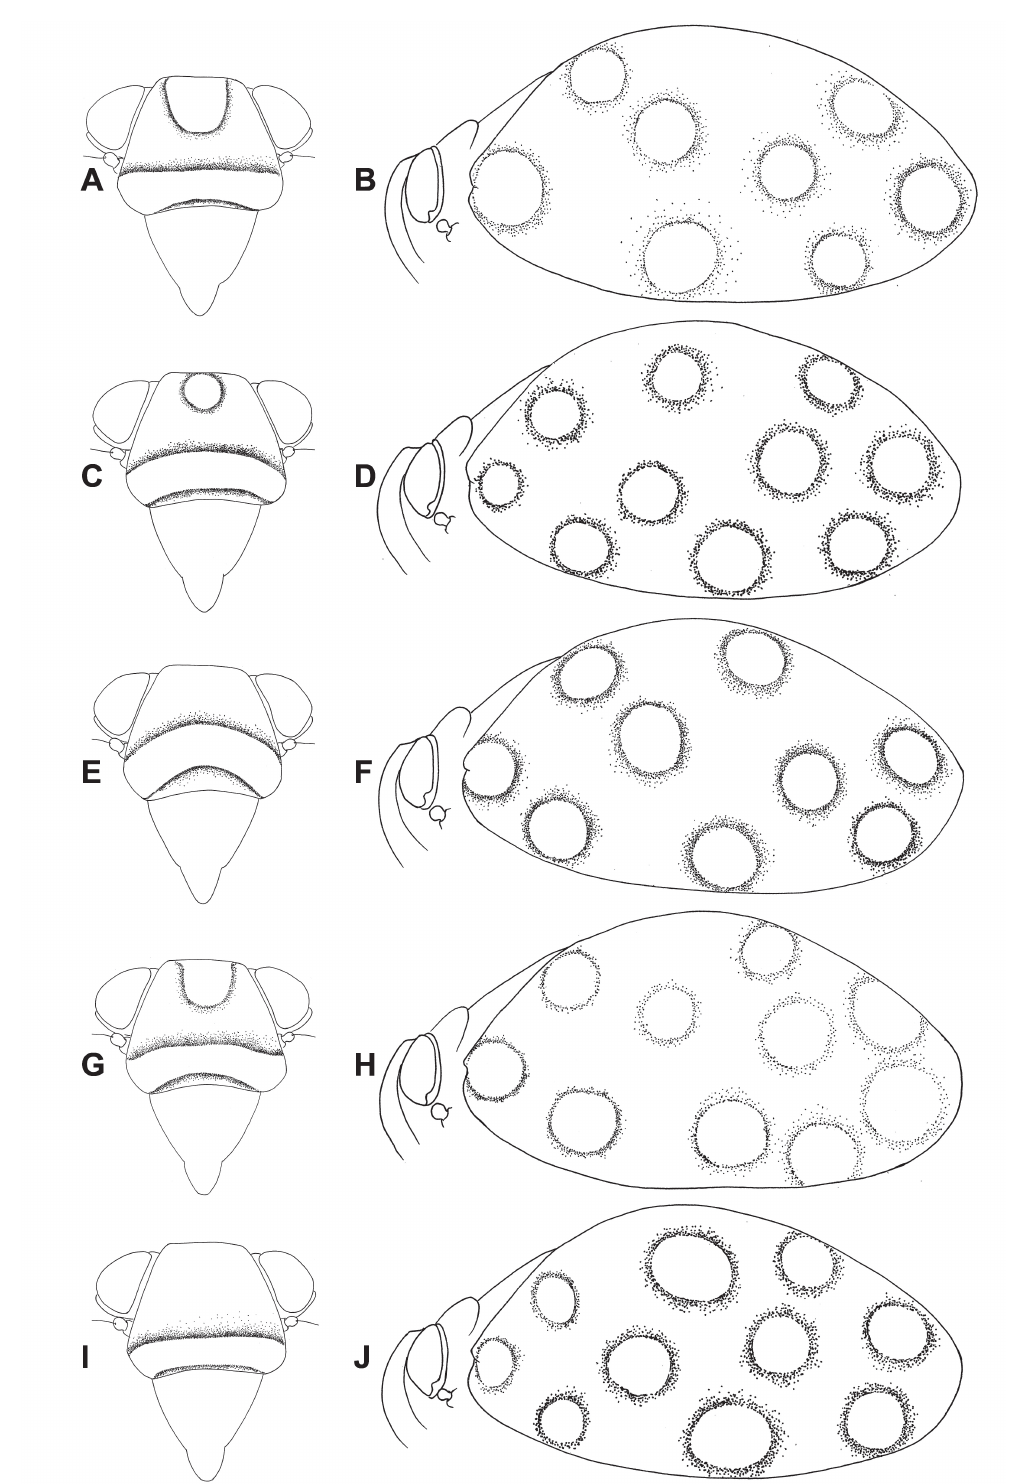
Fig. 2. Gergithus (Maculergithus) subgen. nov., schema of maculation of frons and left tegmen. A–B . Gergithus (Maculergithus) luteomaculatus subgen. et sp. nov. C–D . Gergithus (Maculergithus) multipunctatus Che, Zhang & Wang, 2007. E–F . Gergithus (Maculergithus) nonomaculatus Meng & Wang, 2012. G–H . Gergithus (Maculergithus) tamdao subgen. et sp. nov. I–J . Gergithus (Maculergithus) sp. (drawings by J. Caudron, RBINS; C–F, I–J based on illustrations of